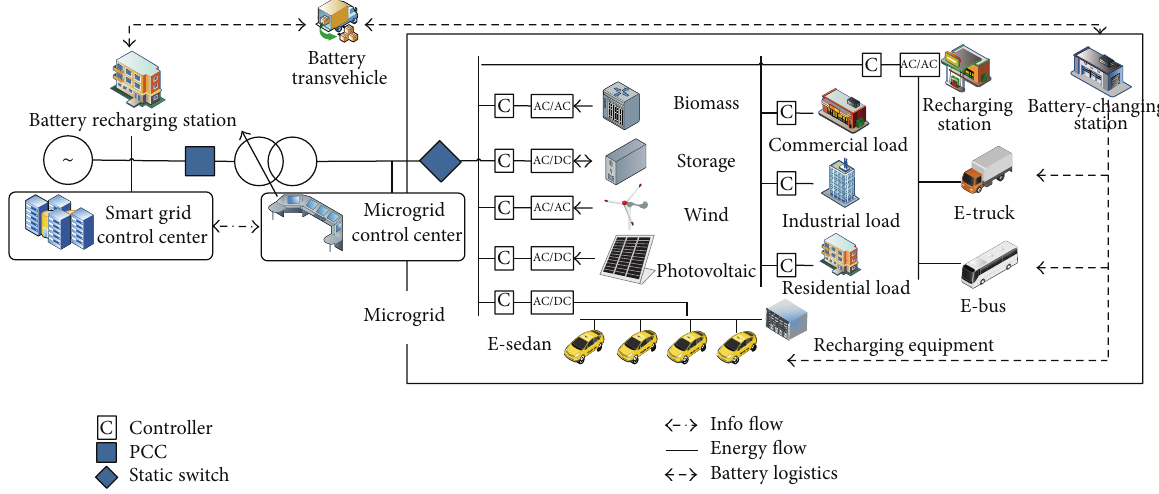
Figure 1: Typical HRES